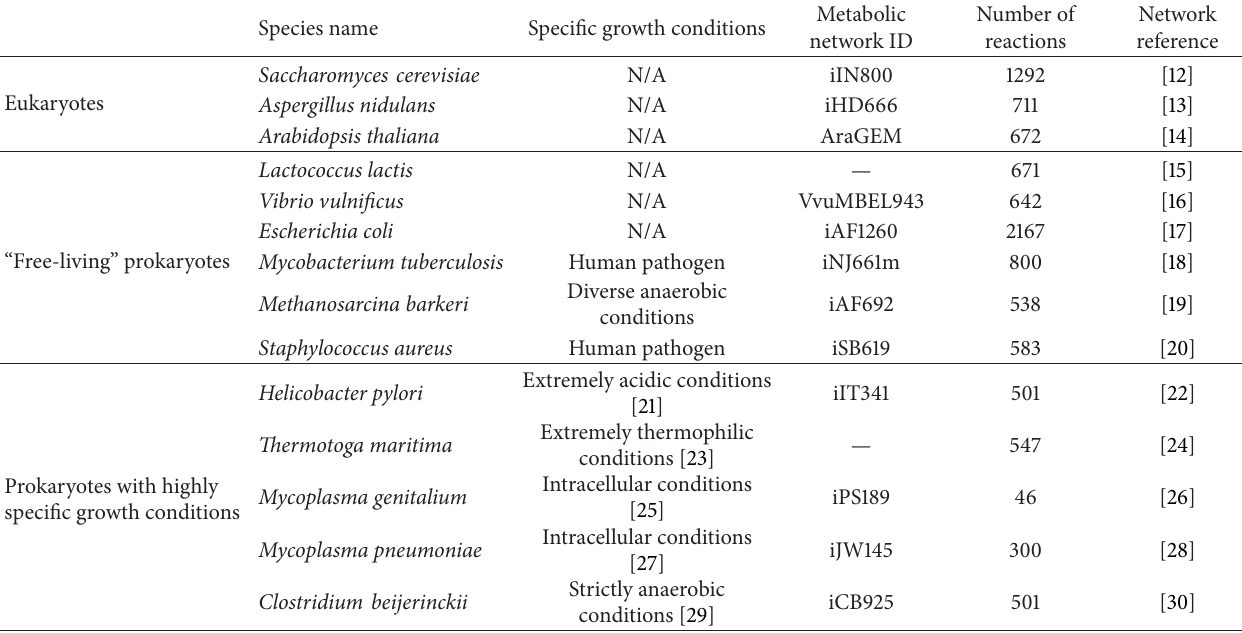
Table 1: List of species used in the present